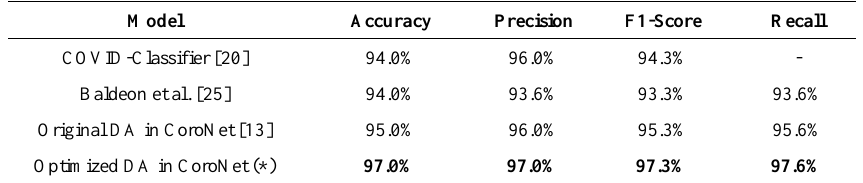
Table 11. Evaluation metrics of the proposed CoroNet with the optimized data augmentation strategy (*) and competing state- of-the-art models on COVID-19 classification on dataset 2. The values presented are as reported in the published papers; a dash means the specific metric has not been